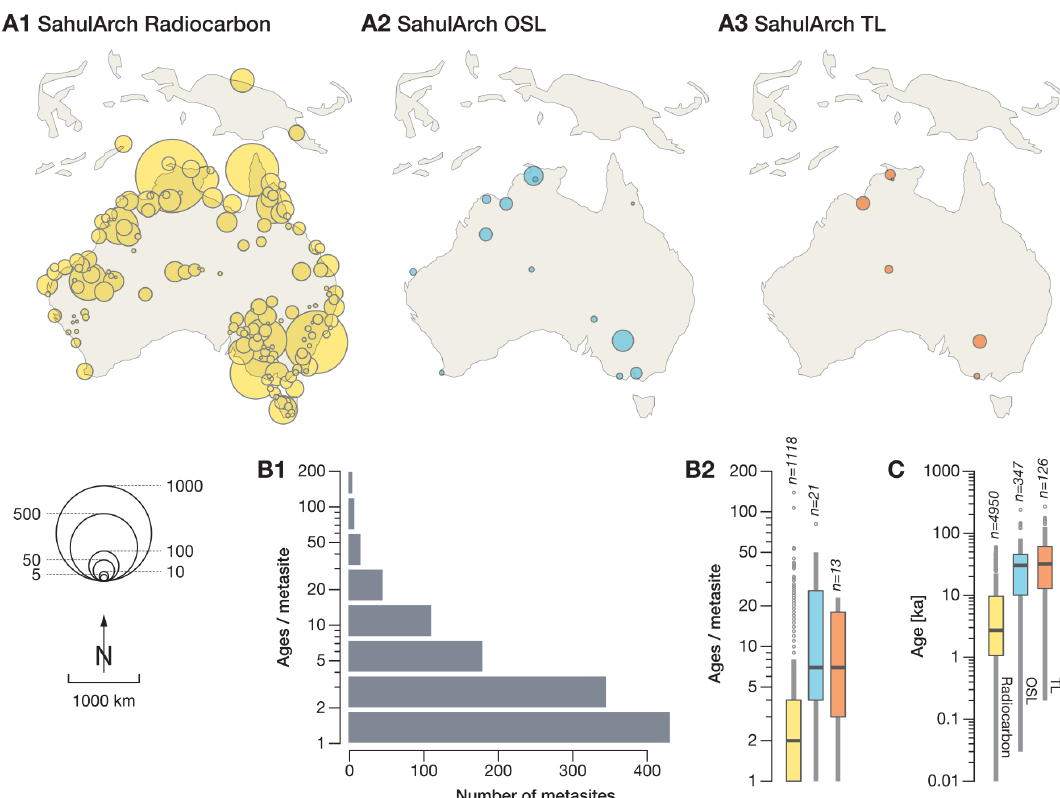
Figure 6. The SahulArch data collection, showing (a) the geographic distribution of sample sites, (b) the number of ages per metasite, and (c) the distribution of ages. The size of circles corresponds to the number of observations in each 50km radius cluster. Box plots are standard interquartile range (IQR) plots with outliers defined as data points > 1 . 5 × IQR. The frequency distribution plot in panel (b1) uses logarithmic bins for clarity. Box plots in panel (c) only include observations with non-zero ages. Box plot colours are as follows: yellow – radiocarbon, blue – OSL, and red – TL. Note that the SahulArch collection is only ∼ 50% complete (see the text and Table